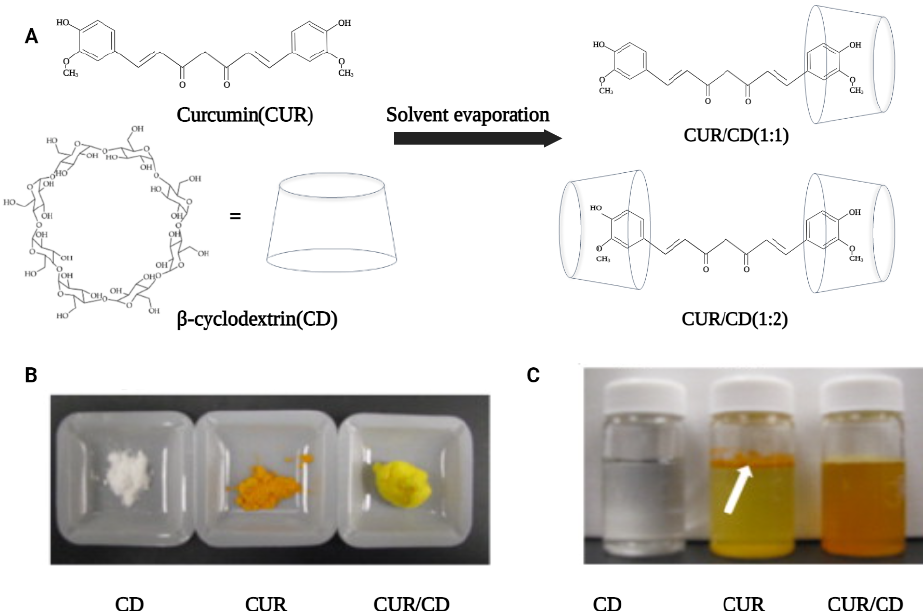
Figure 1. Preparation process and solid-liquid form of CUR/ β -CD. ( A ) Schematic diagram of the preparation of curcumin/ β -cyclodextrin supramolecules by solvent evaporation. ( B ) Solid powder samples of β -cyclodextrin, curcumin and curcumin/ β –cyclodextrin inclusion complex (CUR/CD). ( C ) Aqueous solutions of CD, CUR and CUR/CD inclusion complex (5 mg/mL) [31].